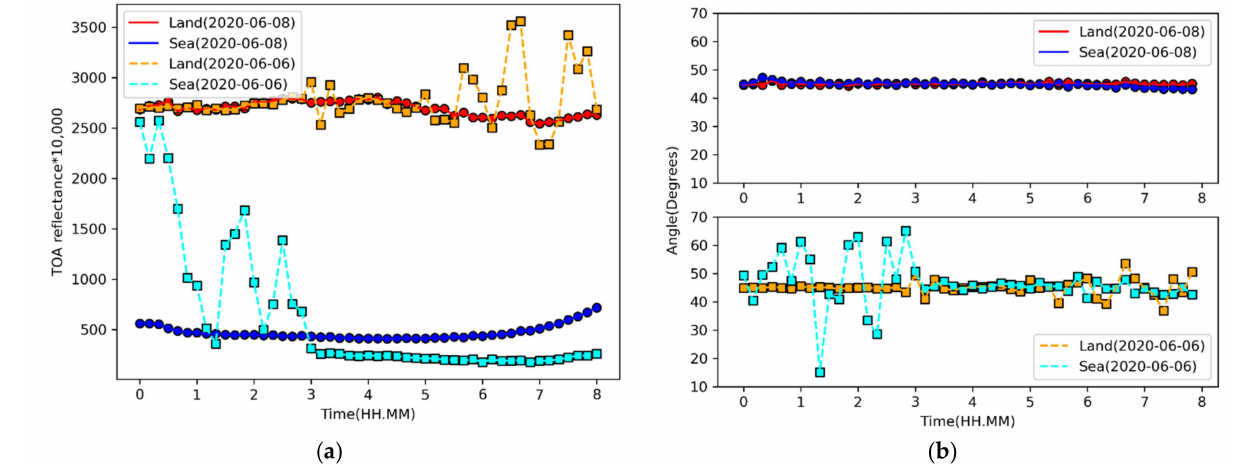
Figure 4. Variations in TOA reflectance of 0.86 µ m and the angle of cloud/clear-sky pixels (6 June 2020 and 8 June 2020) in specific locations (land: 36.76 ◦ N/127.48 ◦ E, sea: 39.01 ◦ N/128.58 ◦ E): ( a ) TOA reflectance and ( b ) angle in degrees over UTC